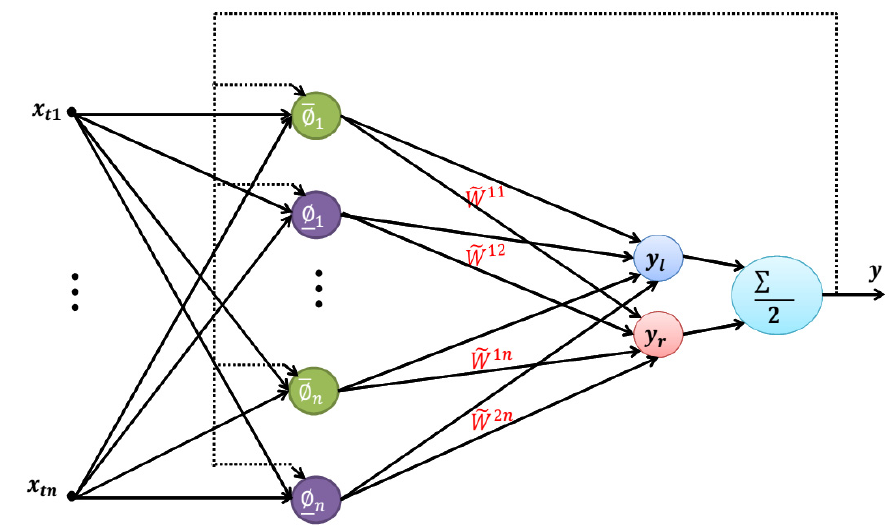
Figure 2. The structure of the proposed type-2 fuzzy neural network.